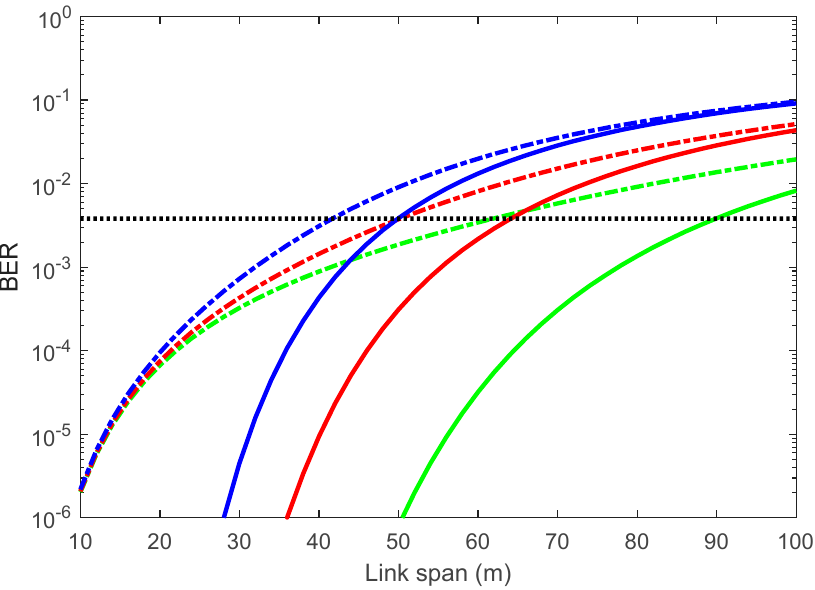
Figure 1. Bit error rate (BER) performance without and with weak to moderate atmospheric turbu- lence (AT) conditions for a range of inter-vehicle distances and θ 1/2